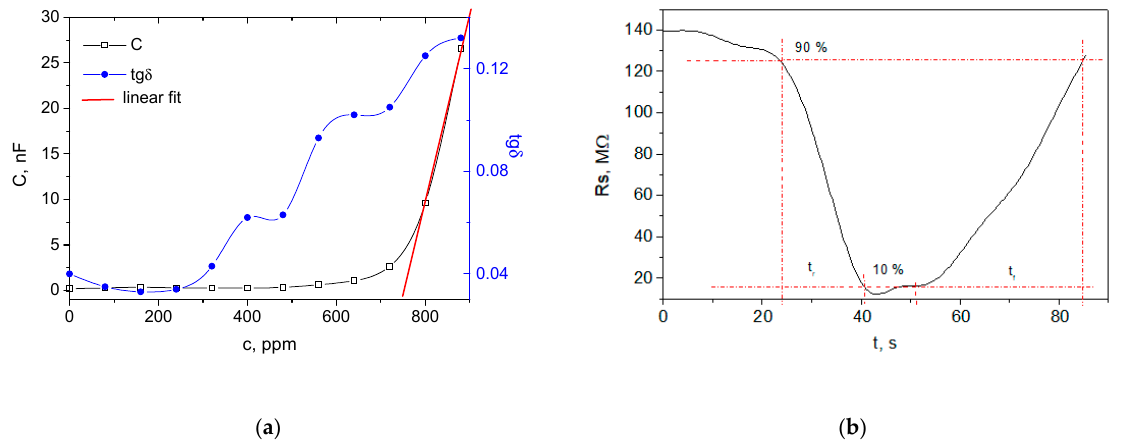
Figure 4. Response of the sensing device with a large non-patterned membrane: ( a ) capacitance and loss tangent changes with the ethanol concentration; ( b ) sensing layer resistance change with the time for response and recovery time determination at 750 ppm.